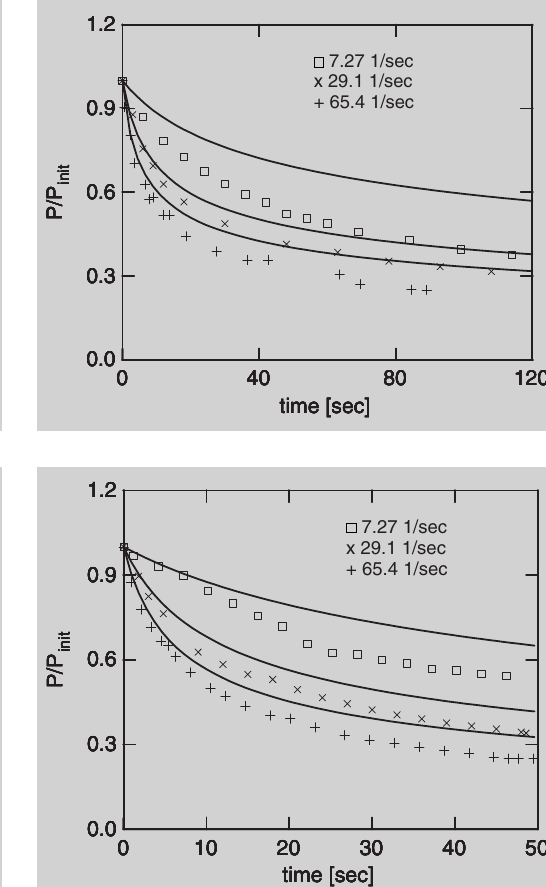
Figure 9 (left above): Decreasing pressure transient for NR compound in 10:1 die at 110˚C Figure 10 (right above): Decreasing pressure transient for NR compound in 30:1 die at 110˚C Figure 11 (left below): Decreasing pressure transient for PVMQ compound in 10:1 die at 120˚C Figure 12 (right below): Decreasing pressure transient for PVMQ compound in 30:1 die at